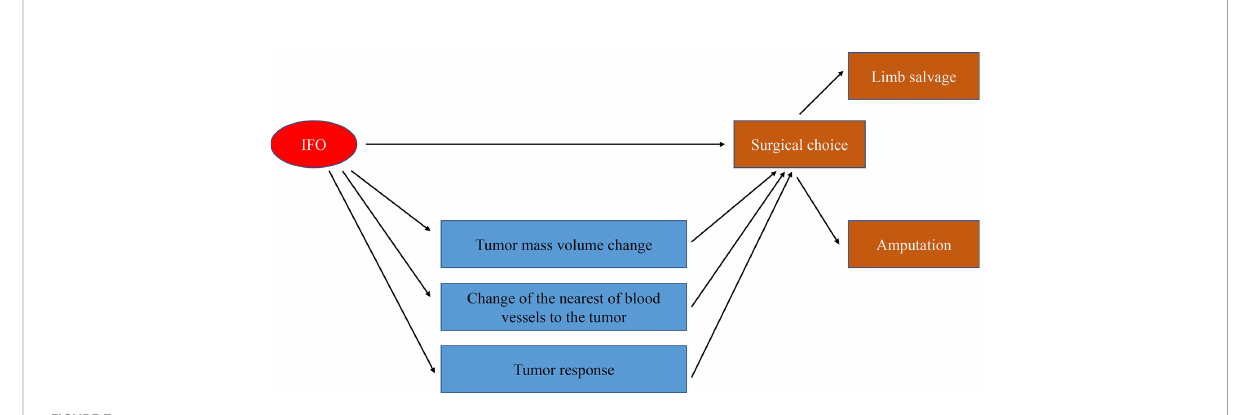
FIGURE 7 IFO may contribute to limb salvage directly and